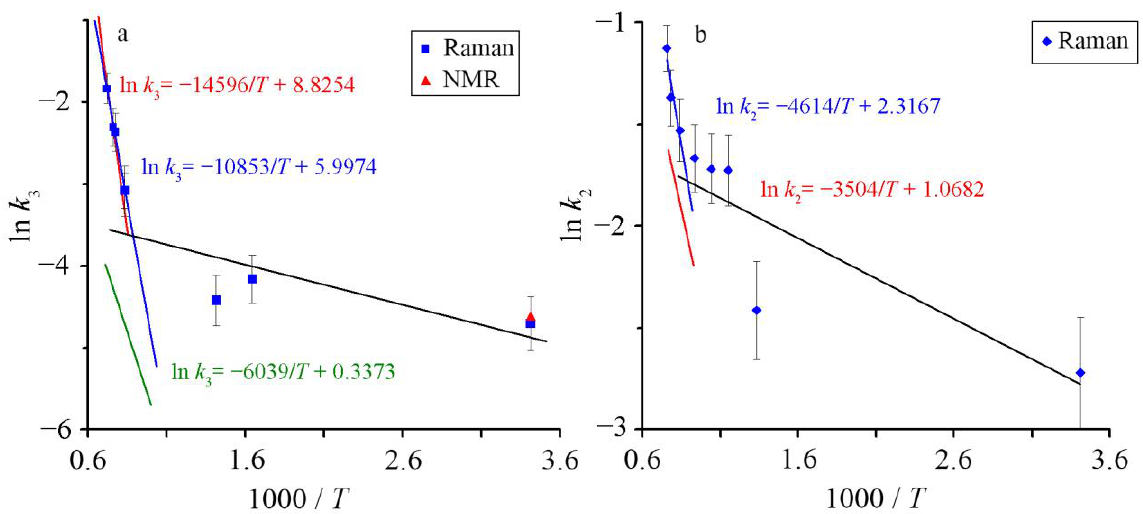
Figure 6. Temperature dependence of the equilibrium constant of Reaction (1) in the 33KS ( a ) and 50KS ( b ) melts according to the modeling results (red line), NIST data (green line) and experimental data: Raman (blue markers) and NMR (red marker) [21].